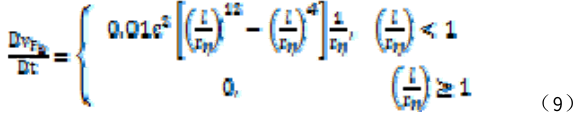
Figure 3. The comparison of different calculation results using different smoothing